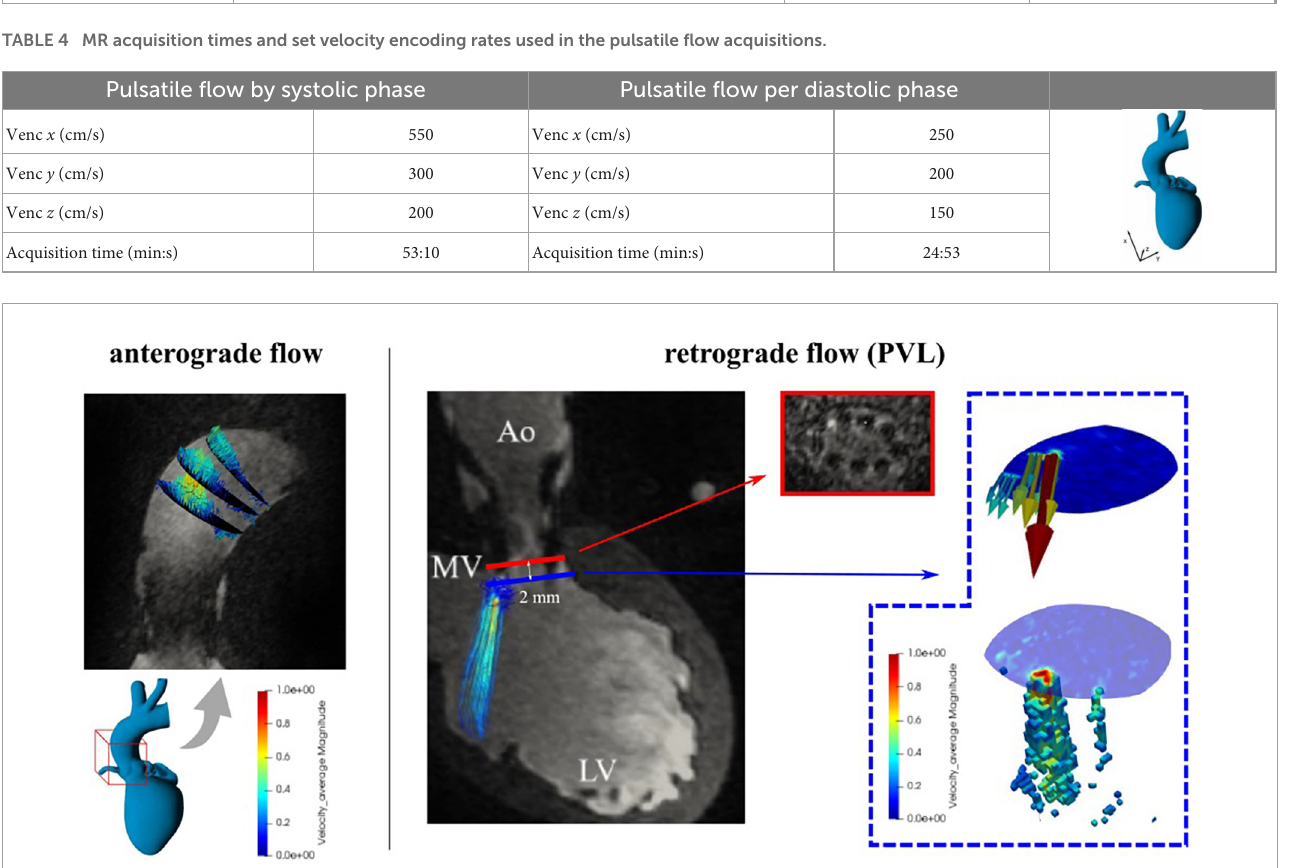
TABLE 4 MR acquisition times and set velocity encoding rates used in the pulsatile flow acquisitions.